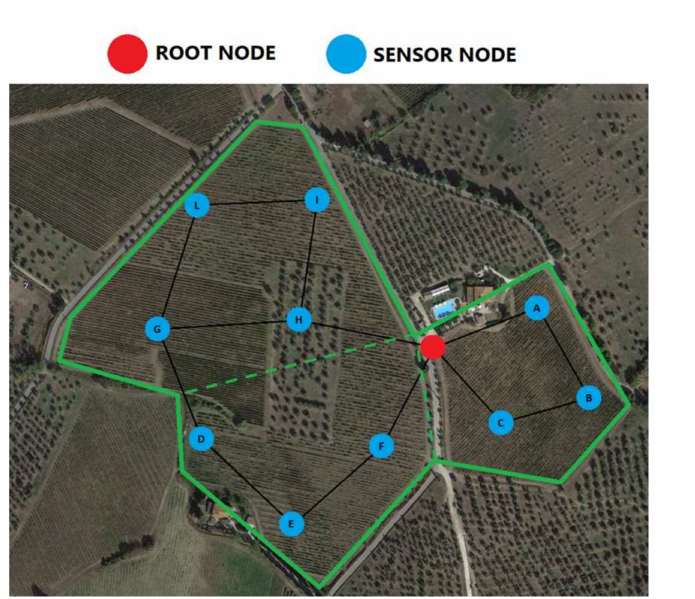
Figure 9. Map of the monitored field showing the real arrangement of the nodes. The continuous green line represents the border of the monitored field, the dotted green lines stand for the division of the three sectors and the black lines represent the wireless connectivity of the network.